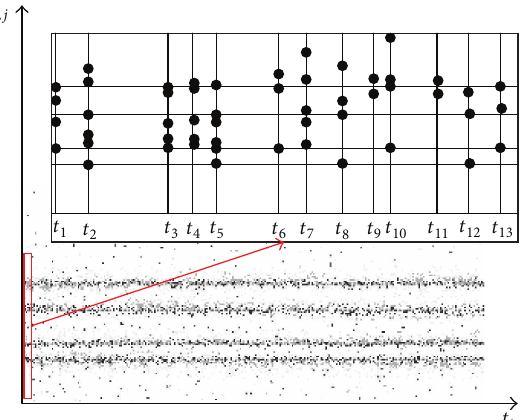
Figure 7: Schematic diagram of plane transformation of instanta- neous